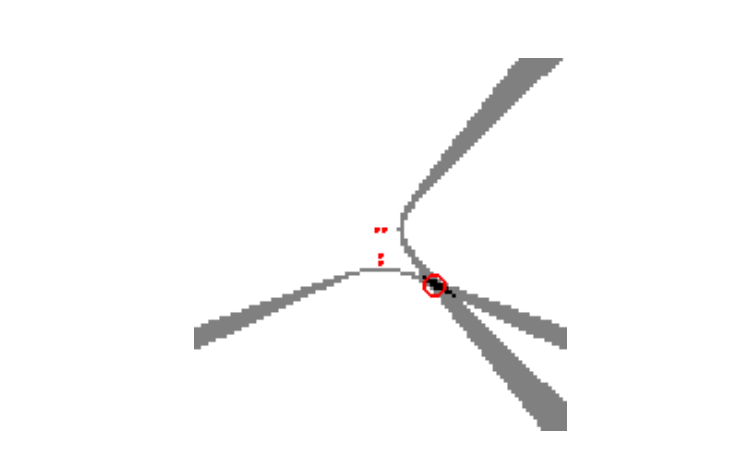
Figure 4. Model content defined for a single active speaker located in the position of the red circle.